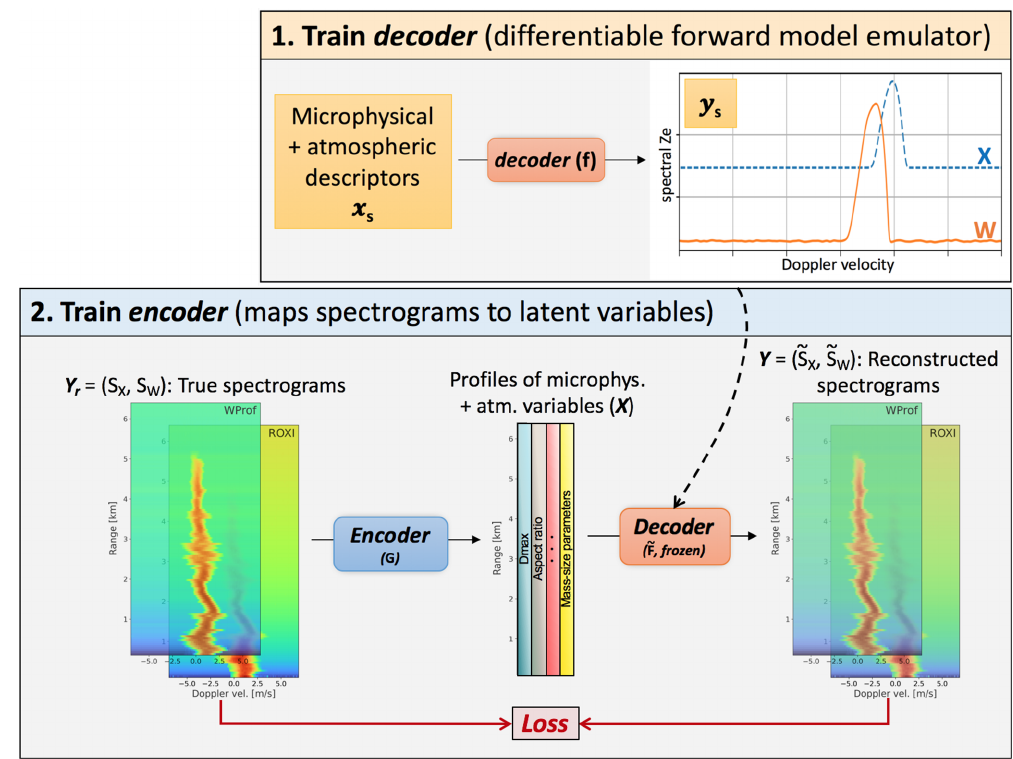
Figure 1. Schematic illustration of the method. The notations are those of Sect. 2.2. The upper right box illustrates that the decoder neural network (NN) is trained to emulate a forward radiative transfer model. The lower box shows the full pipeline where the pretrained decoder is used to reconstruct full spectrograms based on the microphysical properties output by the encoder